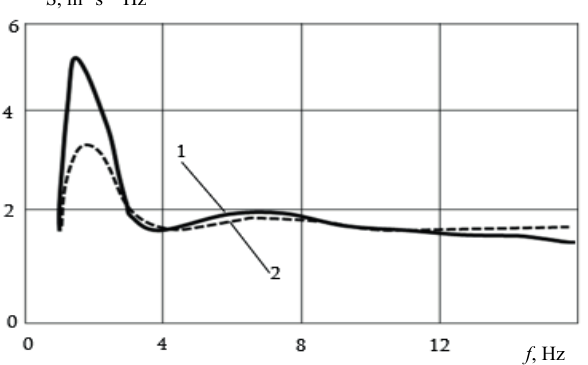
Fig. 15. Vibration protecting characteristic of the suspension at the length of the pendulum arm of 0.30 m: 1) without a recuperator; 2) with an unloaded recuperator; 3) with a loaded recuperator.